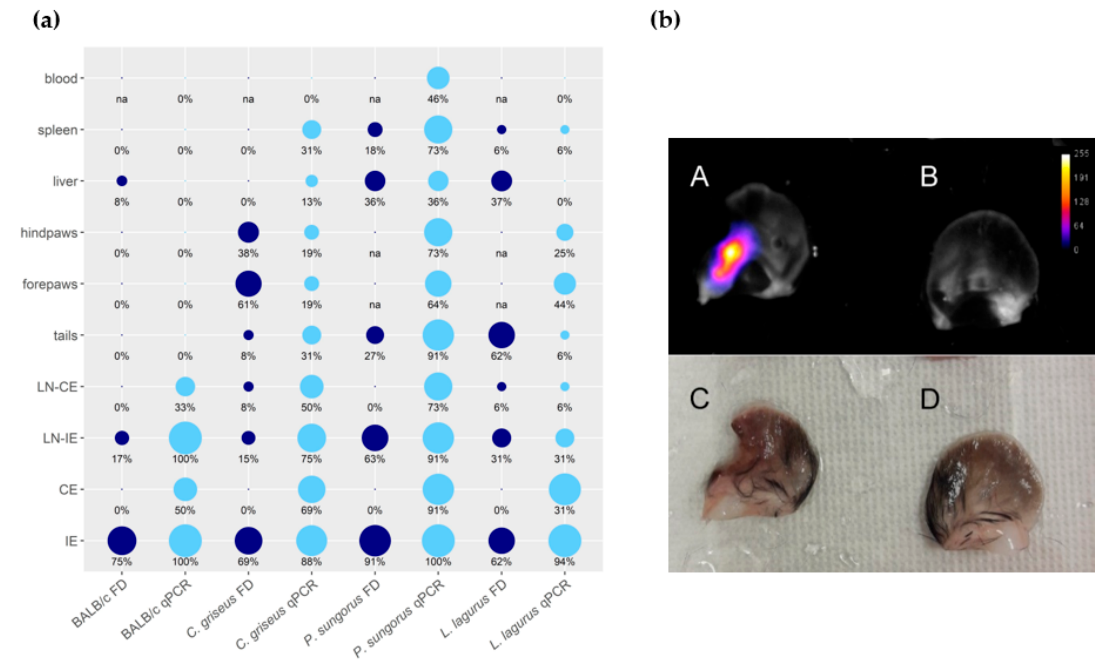
Figure 3. Anatomical distribution of L. major in four rodent species. ( a ) Results of fluorescence detection (FD, dark blue) and qPCR (light blue) presented in the balloon graph where the size of the balloon corresponds to the infection rate, i.e., the percentage of L. major -infected organs from the total sum of tested organs of the same type. IE = inoculated ears; CE = contralateral ears; LN-IE = draining lymph nodes of the inoculated ears; LN-CE = draining lymph nodes of the contralateral ears; na = not analyzed. ( b ) Ears of the C. griseus wetted with saline, photographed by the end of the experiment at week 15 p.i. A, B, images from In Vivo Xtreme optical display; C, D, images taken by Canon EOS 60D camera with Canon MP-E 65 mm f / 2,8 1–5 × Macro objective. A, C—inoculated left ear with ulcerative lesion and 2240 thousand parasites detected by q PCR. B, D—contralateral right ear with no external manifestation of the disease and 16.8 thousand parasites according to qPCR.